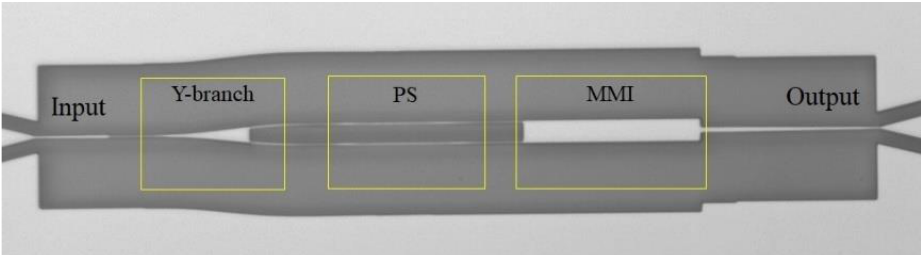
Figure 7. Microscope image (×1000 times) of fabricated silicon E 00 -E 10 mode converter.